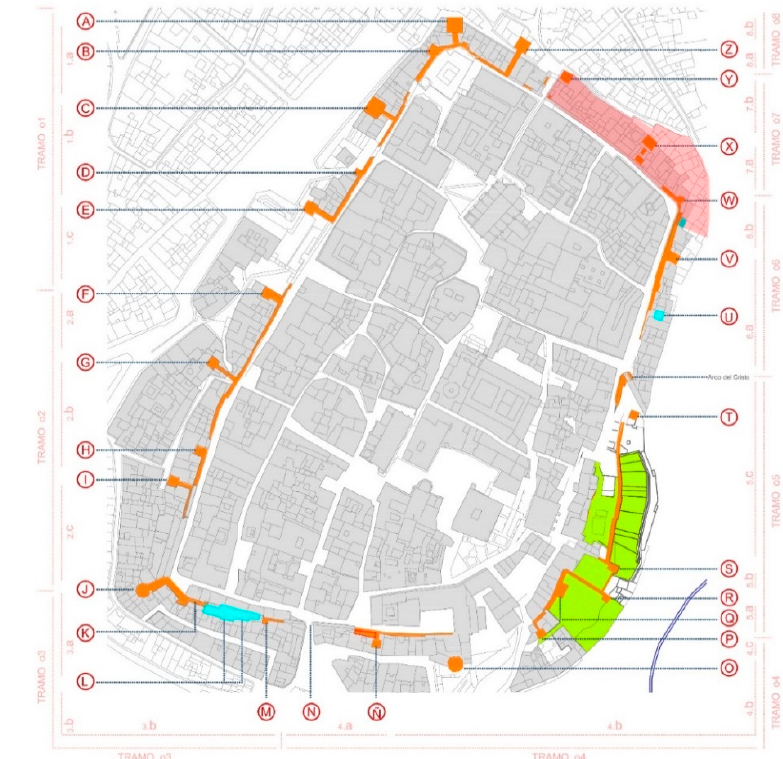
Figure 1. Location map of the intervention. A—garbage tower; B—Spain arch street tower;